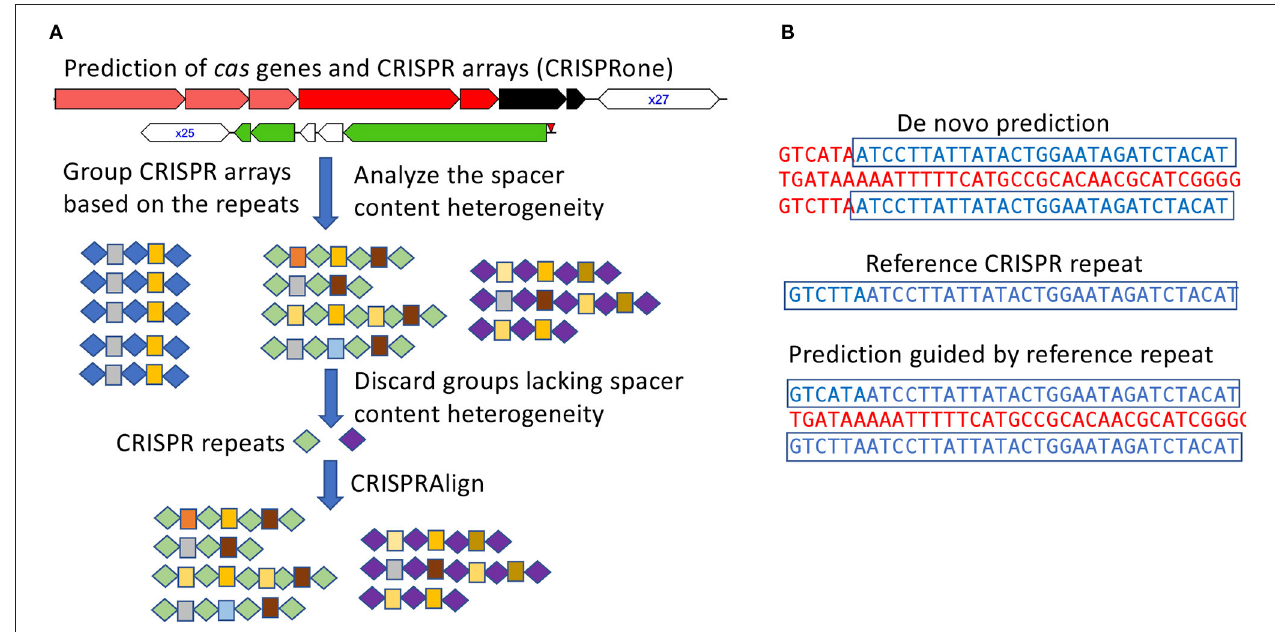
FIGURE 1 | Annotation of CRISPR–Cas systems in all genomes of the pathogens. (A) CRISPR arrays identified from all isolates for a pathogen are analyzed in groups such that false arrays can be identified and discarded; In this illustration, repeats and spacers are represented as diamonds and boxes, respectively, and the same repeats/spacers are highlighted in the same color. (B) using checked CRISPR repeats (as the references) to guide the characterization of CRISPR arrays.